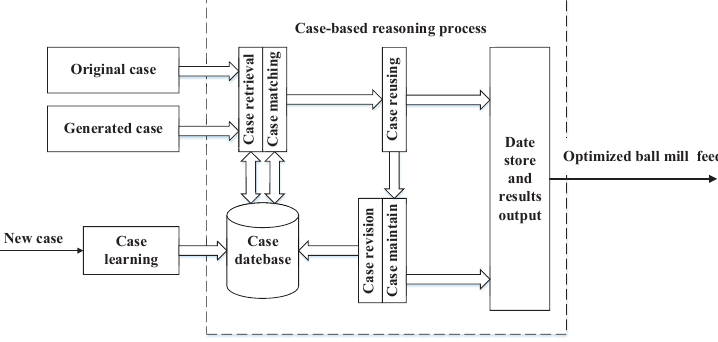
Figure 3. CBR-based optimization strategy for ball mill